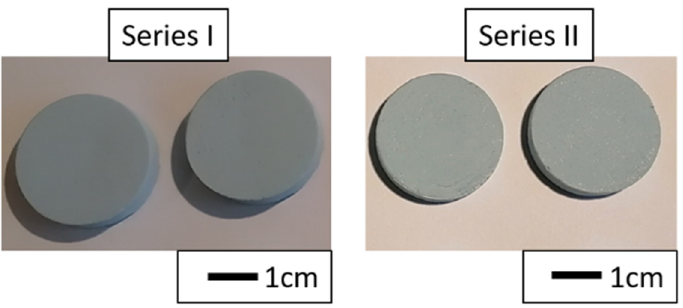
Figure 7. Typical samples obtained by the slip casting method in the raw state.